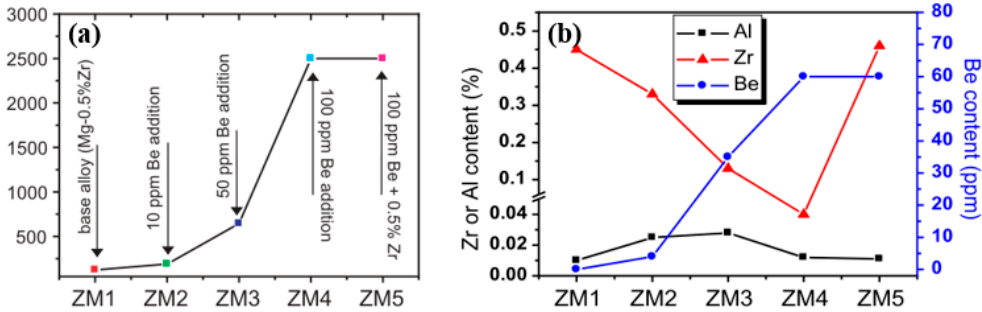
Figure 11. ( a ) Grain size as a function of Be addition. ( b ) Be, Al and Zr contents in alloys. ZM1: base alloy Mg-0.5% Zr; ZM2: 10 ppm Be addition; ZM3: 50 ppm Be addition; ZM4: 100 ppm Be